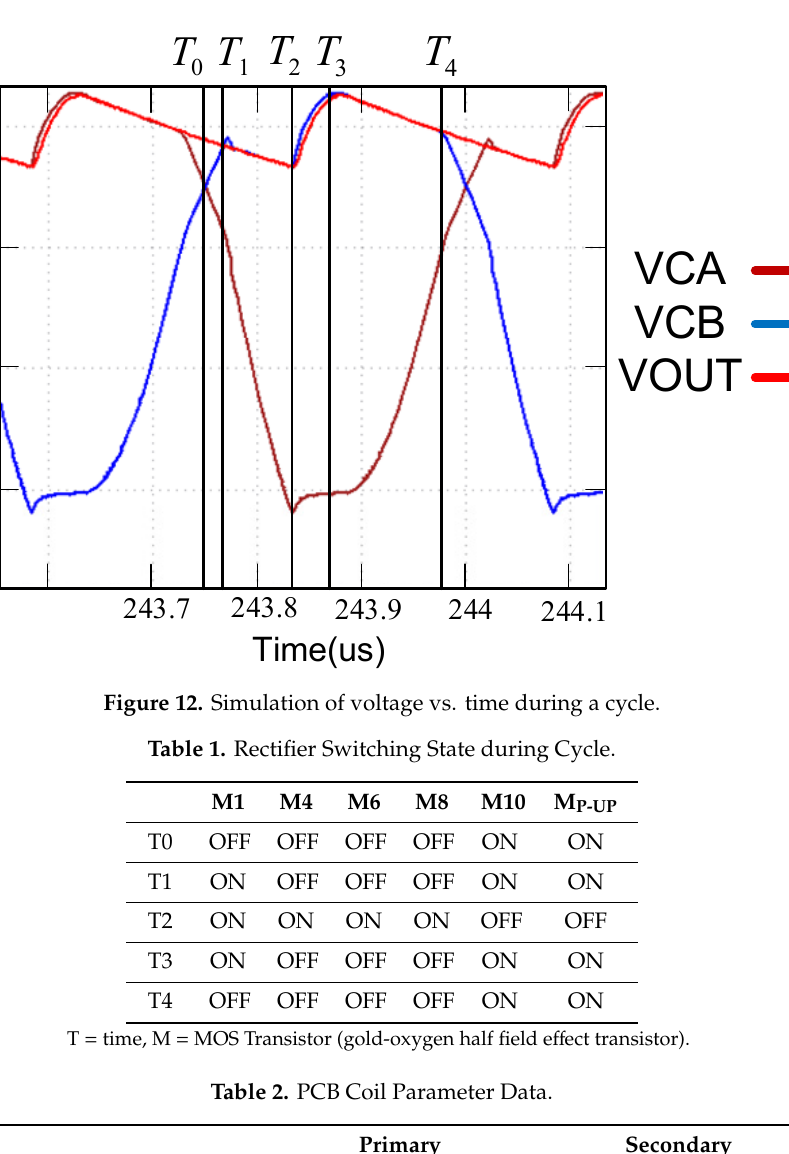
Figure 11. Comparative rectifier equivalent simplified diagram [10].